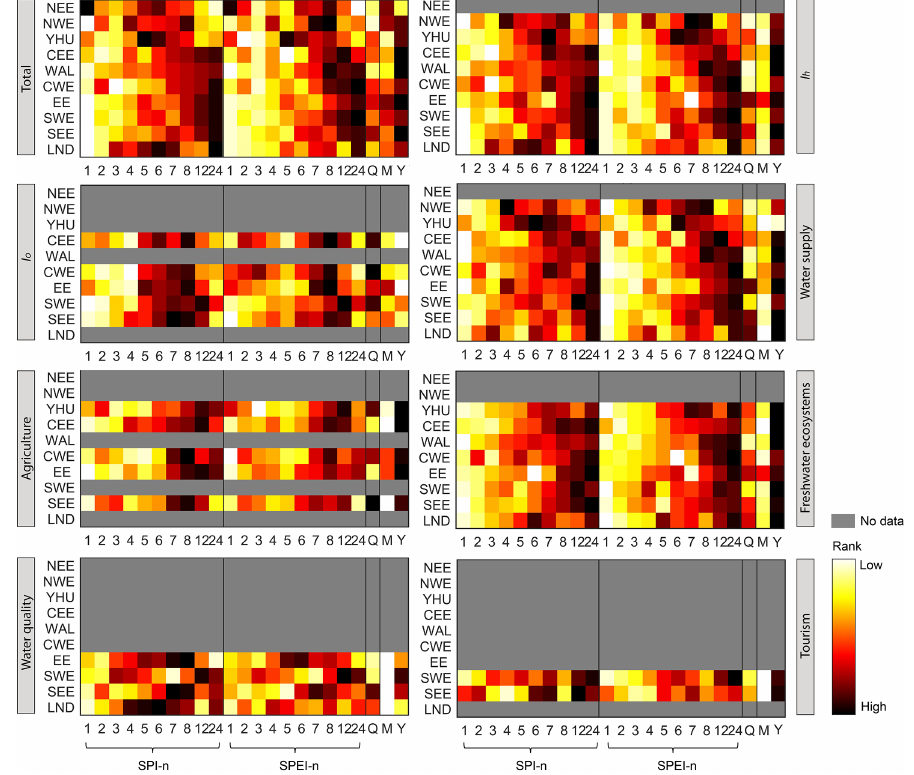
Figure 6. UK: ranks of predictor importance during random forest construction for total impacts, hydrological drought impacts ( I h ), impacts due to other types of drought ( I o ), and selected impact categories per NUTS1